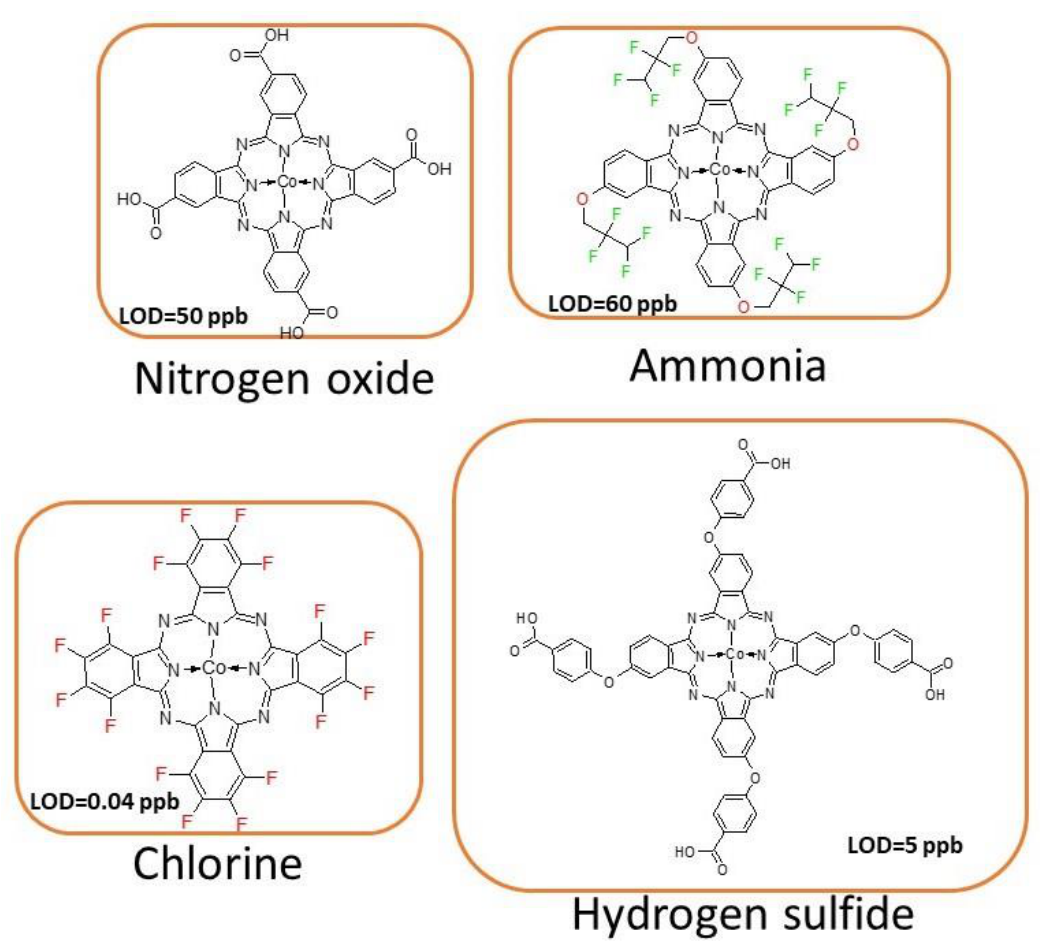
Figure 6. The chemical structures of phthalocyanines possessing lowest LOD in determination of selected gases.